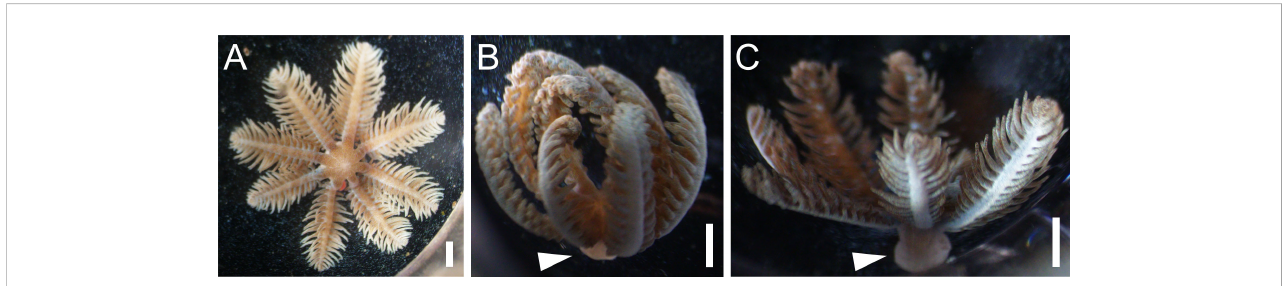
FIGURE 3 Oral discs at different stages of development of basal attachment disc. (A) Oral disc from amputated polyp, attached but basal disc not yet visible. (B) Oral disc with basal attachment disc forming. (C) Oral disc with fully formed basal attachment disc. Arrowheads indicate basal disc. Scale bars 1